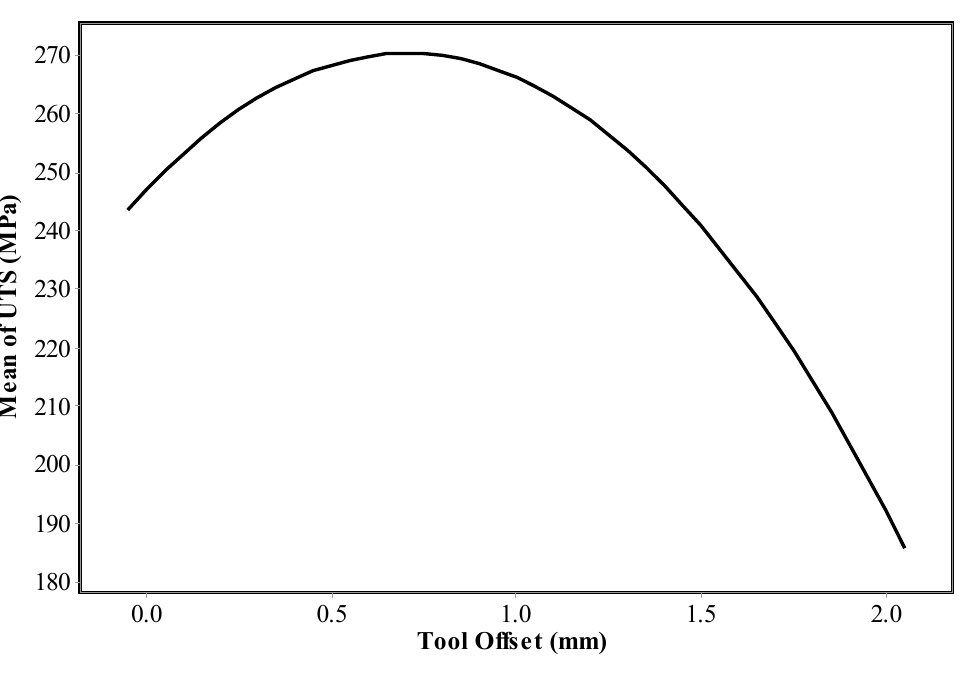
Figure 6. UTS vs. tool offset for welded specimens.